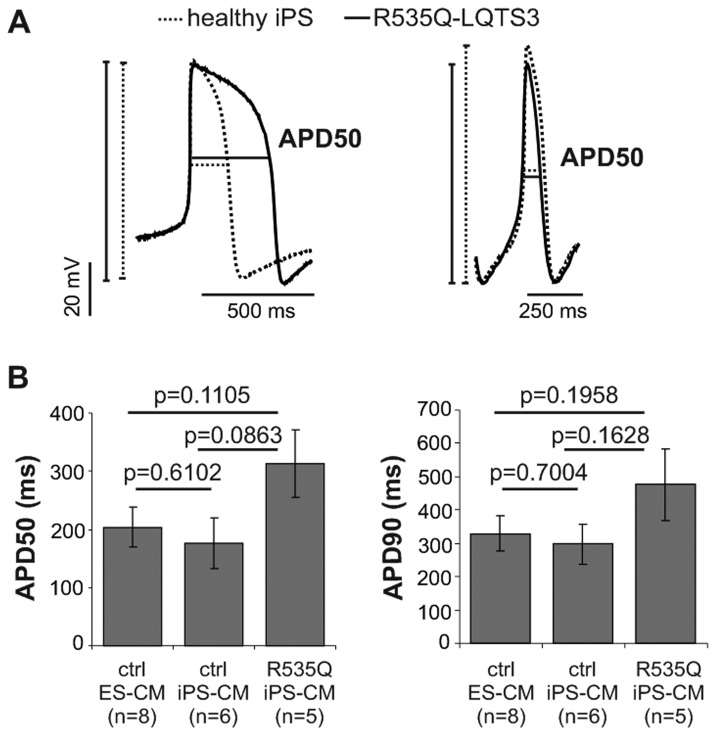
Patch clamp recordings of action potentials in R535Q-LQTS-3 iPS cell-derived CM.(A) Overlay of trace from R535Q-LQTS-3 and healthy cells representing the difference in action potential duration at 50% of repolarization (APD50) in ventricular (left) and atrial (right) like cells. (B) Statistical analysis of the differences in APD90 and APD50 of control and diseased cells.